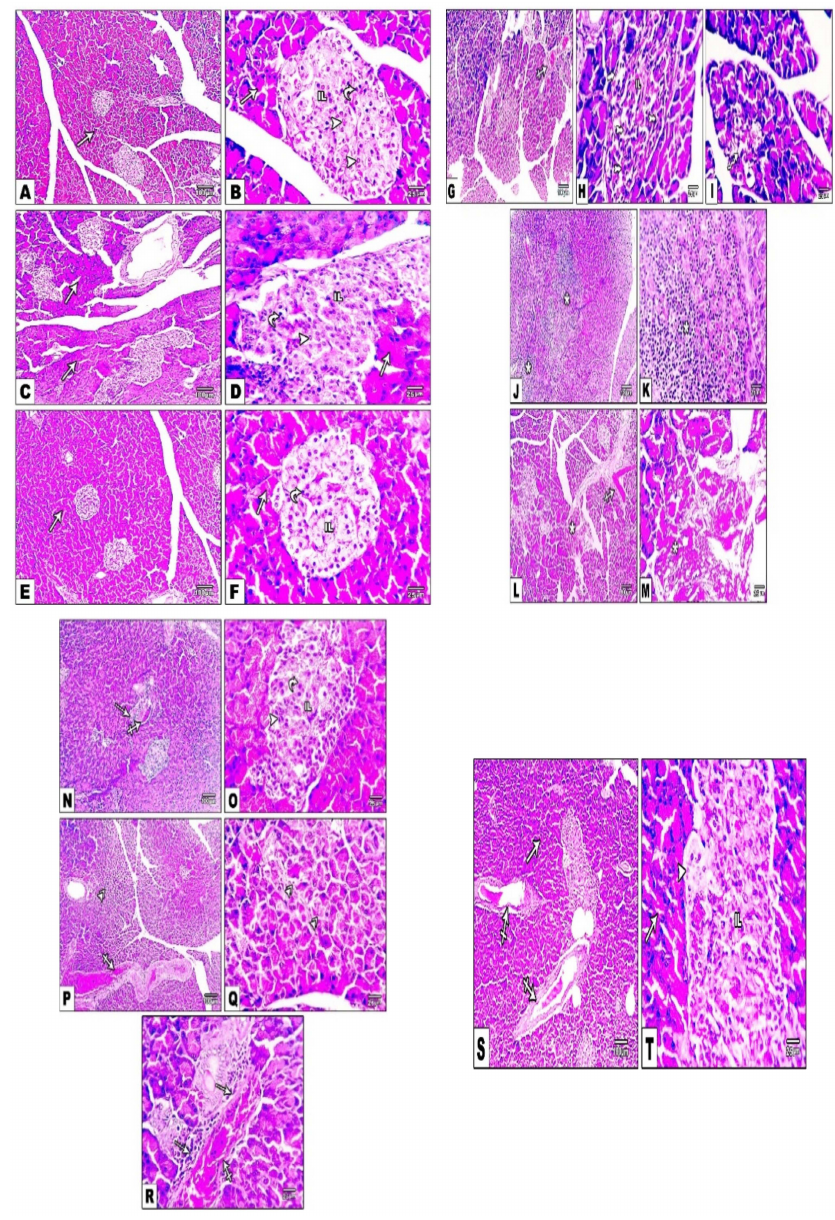
Figure 14. Pancreatic sections from normal ( A , B ), CANA ( C , D ) and INDA ( E , F ) CTRLs revealing well-preserved exocrine acini (arrows) and islets of Langerhans (IL); α (curved arrows) and β cells (arrowheads) in diabetic CTRL ( G – M ) showing congestion (crossed arrows), vacuolated exocrine acini (wavy arrow), and pyknotic nuclei in most α - and β -cells (rocket arrows) in the islets of the Langerhans (IL), confluent area of necrosis (stars), shrinkage of the pancreas, and vacuolation of β cells (short arrow). Pancreatic sections from the CANA-treated group ( N – R ) showing restored α (curved arrows) and β (arrowheads) cells, congestion (crossed arrows), focal damage to the exocrine acini (double-headed arrows) and infiltration of several perivascular mononuclear cells (dotted arrows). Pancreatic sections from the INDA-treated group ( S , T ) showing mild vacuolation of β cells (arrowheads), congestion (crossed arrows), and normal exocrine acini (arrows). Low magnification: 100 × bar 100; high magnification: 400 × bar